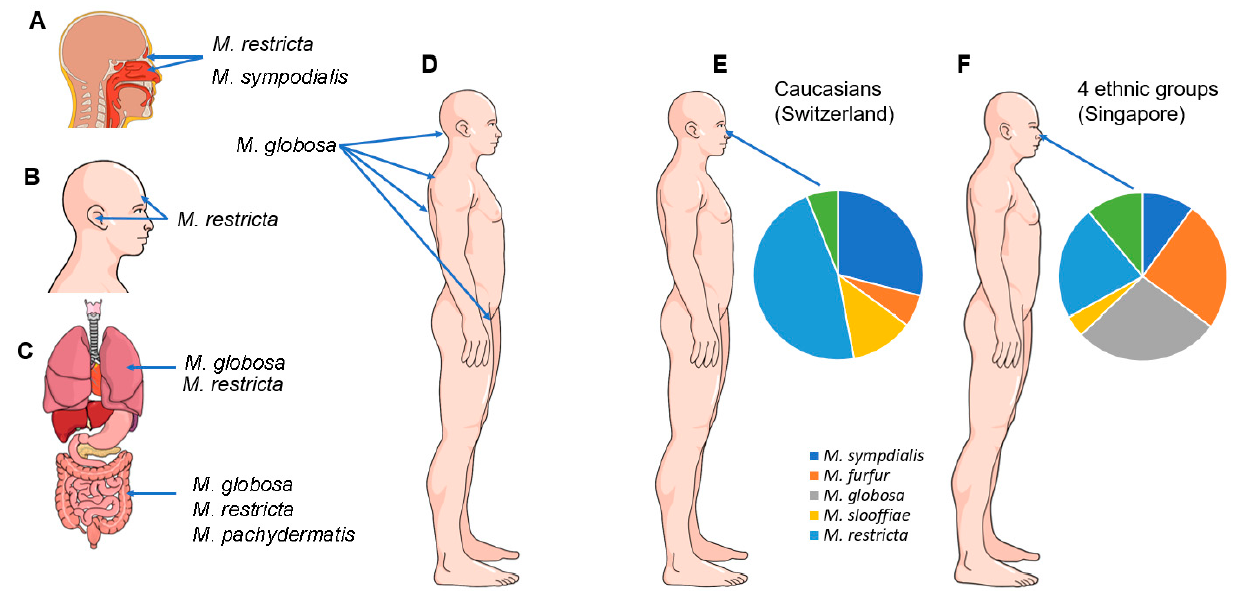
Figure 1. Predominant Malassezia species found as commensals in the sinonasal cavity ( A ), on the skin of the forehead and external ear canal ( B ), in the lungs and gastrointestinal tract ( C ) and on the skin of the occiput, back and groin ( D ). The relative diversity of Malassezia species found in healthy skin is shown in ( E , F ). The predominant species isolated from the culture of the skin on the side of the nose of Caucasians in Switzerland were M. restricta and M. sympodialis, while M. globosa was absent. In contrast, sampling from the skin of the noses of 4 ethnic groups (Chinese, Malay, Indian and Caucasian) in Singapore overall revealed M. globosa , M. furfur and M. restricta to be the dominant species [96].